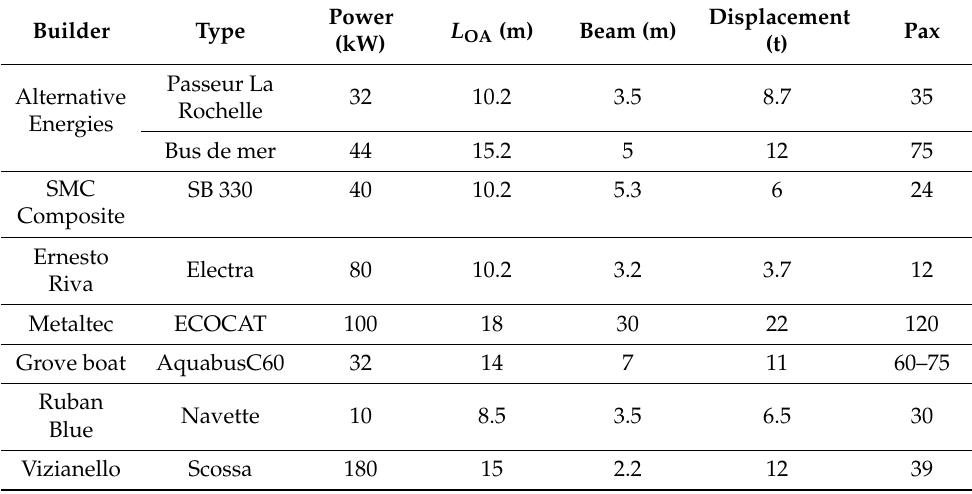
Table 2. Database of zero emission small passenger